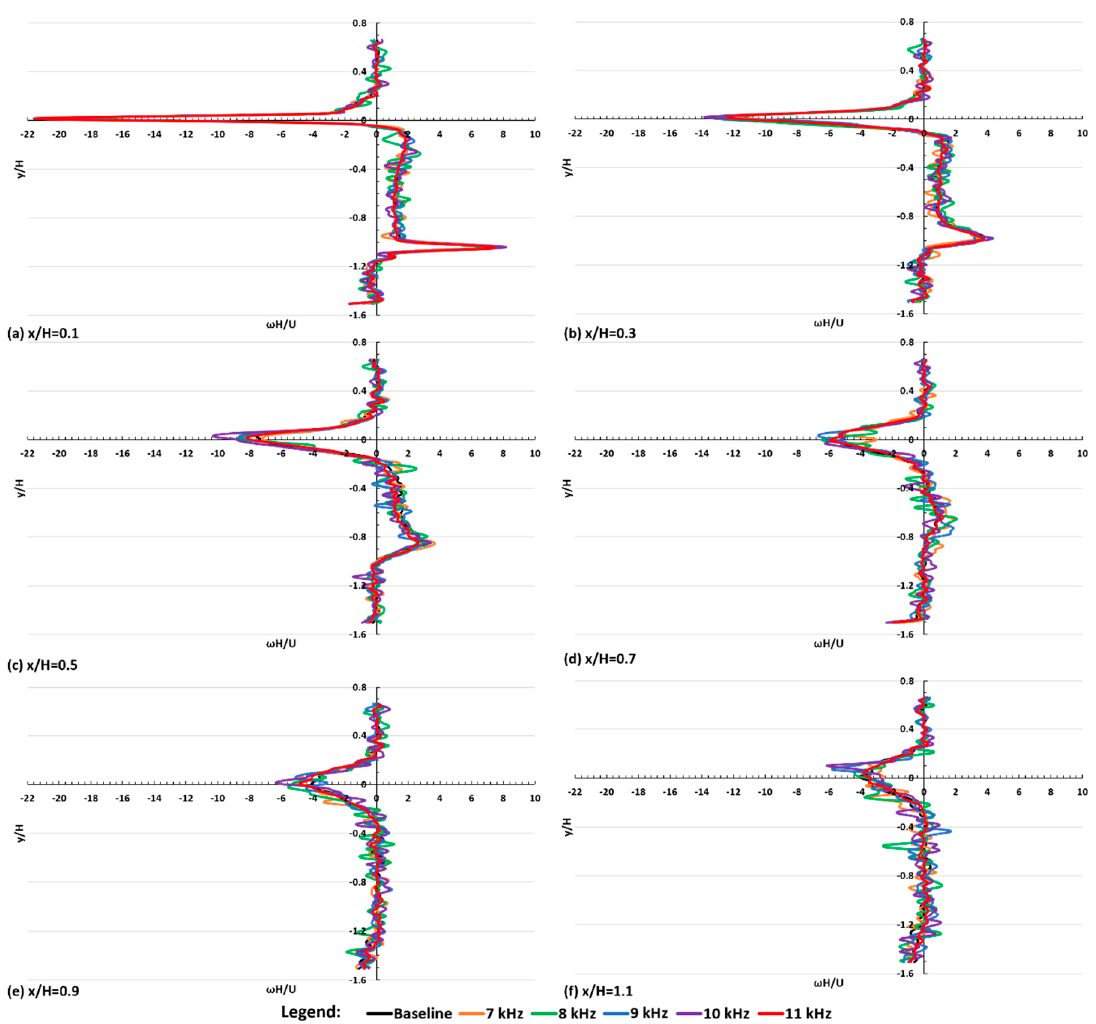
Figure 17. Normalised z-vorticity profiles at various normalised x-locations along the wake region. x / H = ( a ) 0.1, ( b ) 0.3, ( c ) 0.5, ( d ) 0.7, ( e ) 0.9, and ( f ) 1.1.